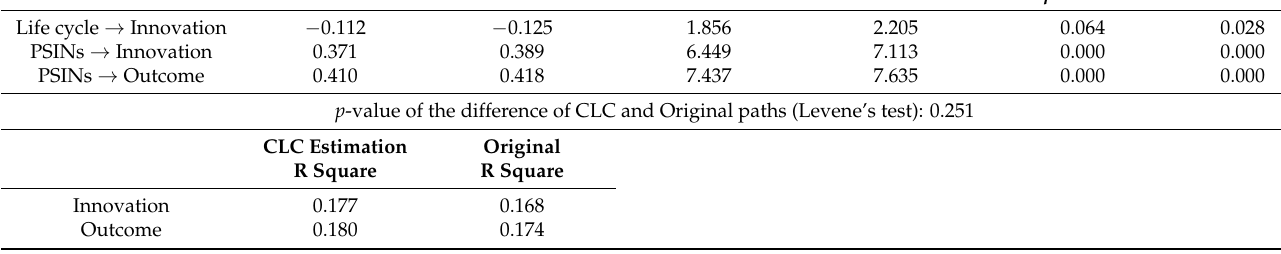
Table A2. Comparison of HOC-model Path Coefficients, t-Values, p -Values and R-square values—CLC Approach and Original.